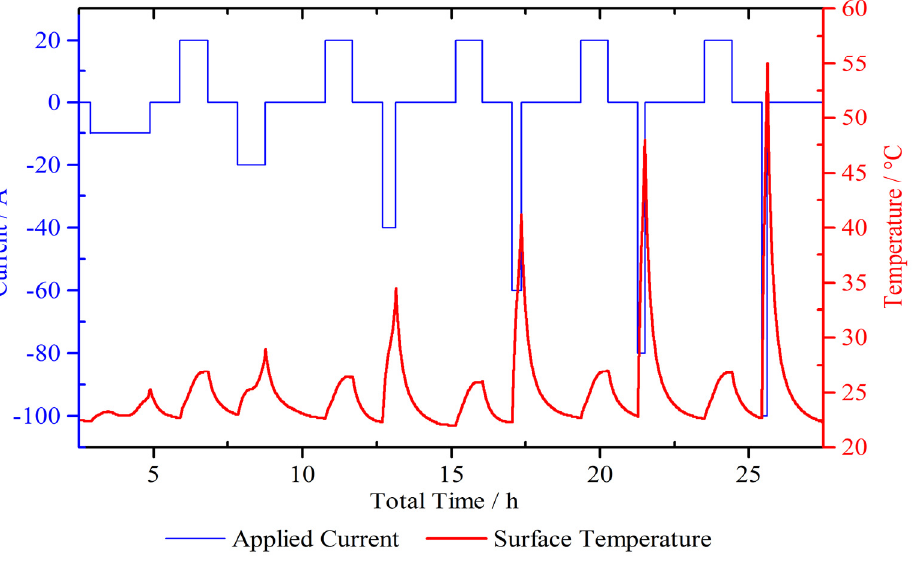
Figure 3. Thermistor (placed near the positive tab of the cell) based temperature profile (red line) of NMC cell and corresponding load profile (blue line) during continuous charge at 20 A and discharge at 10 A, 20 A, 40 A, 60 A, 80 A, and 100 A. Discharge is denoted by negative